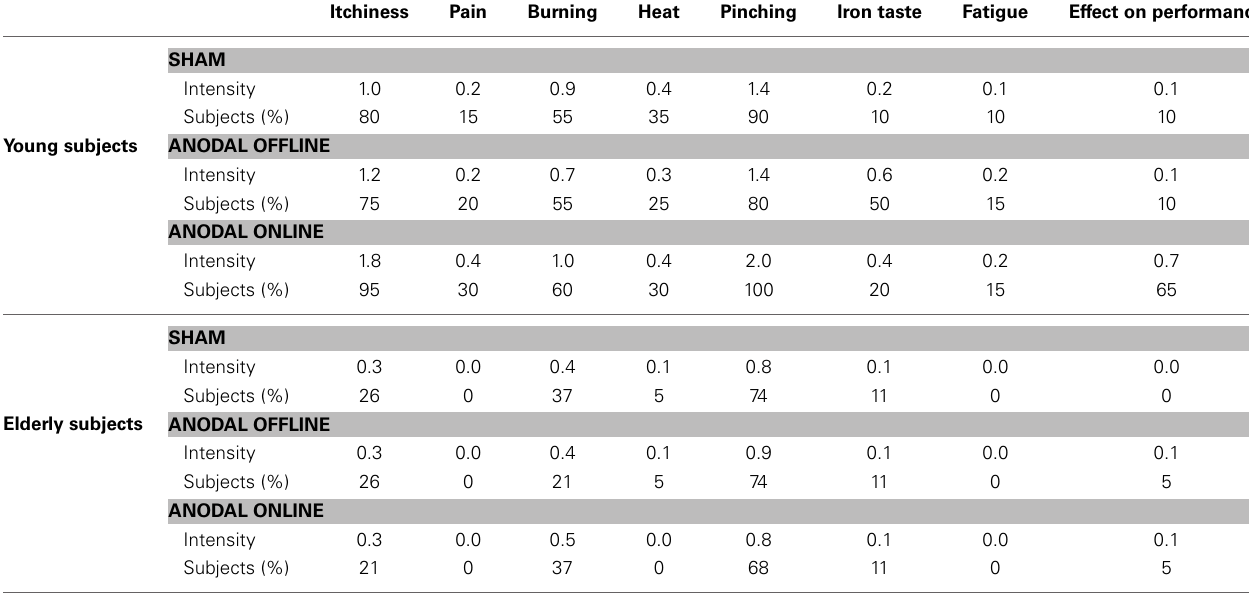
Table 2 | Mean intensity of the sensations reported by the subjects after transcranial direct current stimulation (tDCS) and the percentage of subjects who reported a certain